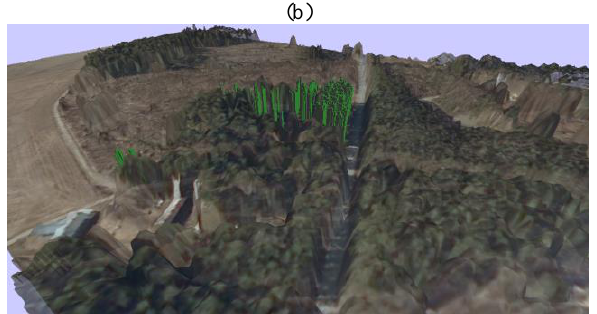
Figure 2. Visualization of storm damages. a) The storm damage analysis can be performed on-demand for user selected cadastral parcel. b) Fallen trees are visualized in the 3D-model as green vertical columns, together with the DTM and the surface model representing the situation after the